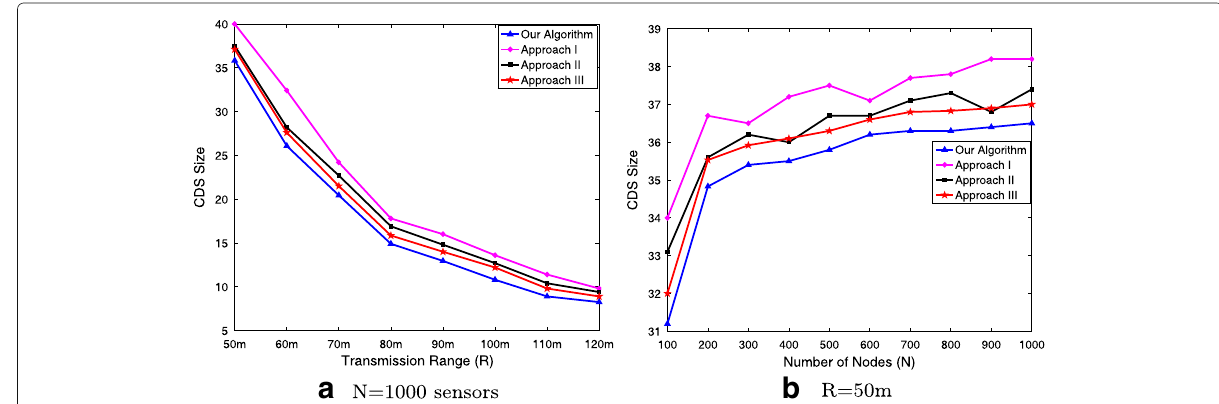
Fig. 5 Comparing results in the 300 × 300 m 2 detection area. a The average performance of four algorithms when N = 1000 sensors and R changes from 50 to 120 m. b The average performance of four algorithms, when R = 50 m and N varies between 100 and 1000